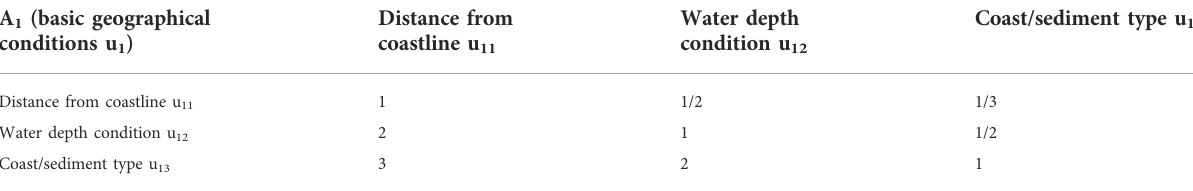
TABLE 6 Quantitative judgment of the relative importance of indexes for basic geographical conditions.